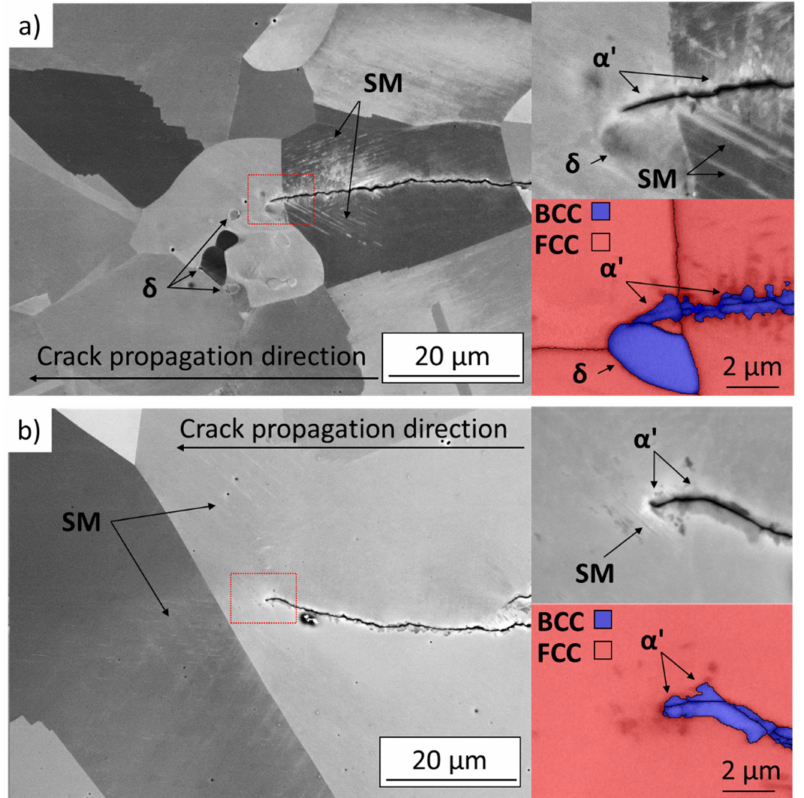
Figure 9. SEM images of the microstructure in the crack tip vicinity with the crack arrested at the threshold stress intensity factor, R = 0.7, 23 ◦ C; ( a ) as-received state, ( b ) solution-annealed state. Detail of the areas marked by red rectangle is shown together with corresponding phase maps (acquired by EBSD).